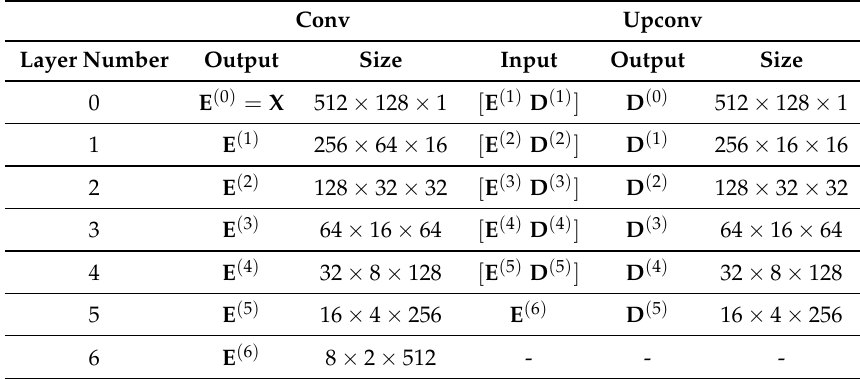
Table 1. U-Net architecture for singing voice